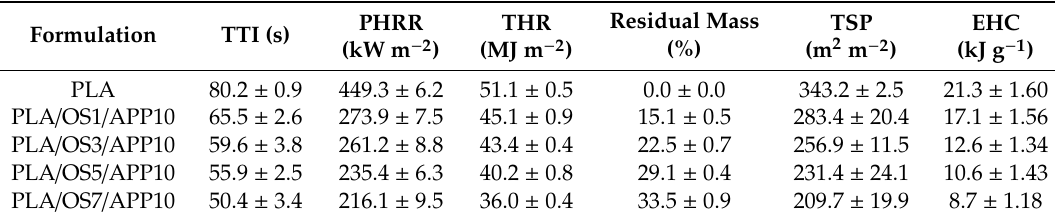
Table 7. Cone calorimetry